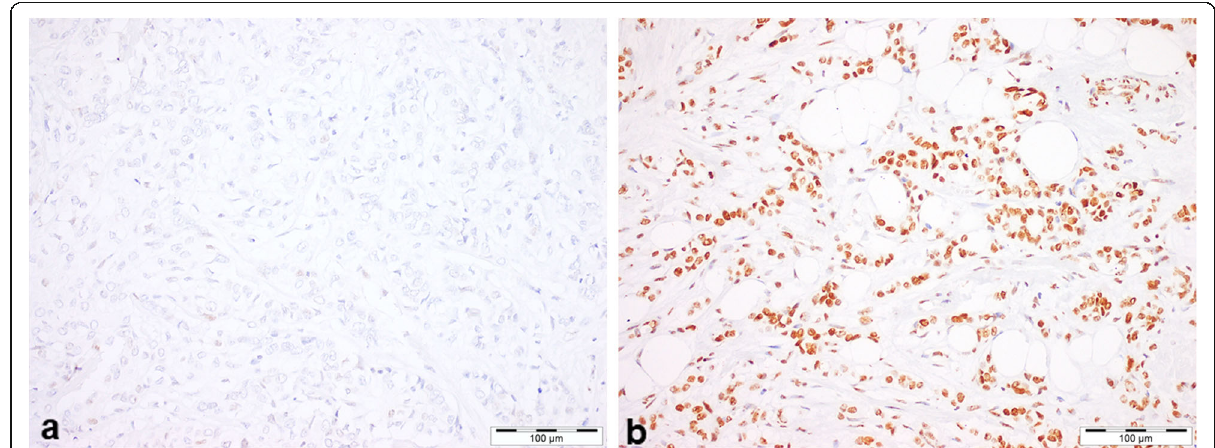
Fig. 1 Representative image of H3K27me3 immunoexpression in breast cancer tissue samples. a low expression score and b high